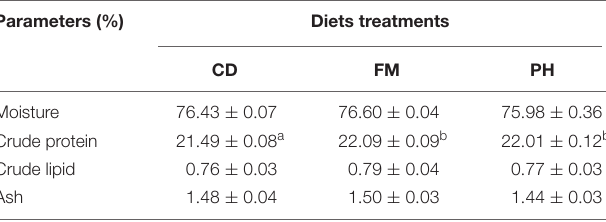
FIGURE 2 | Expression levels of tor , s6k and 4e-bp in muscle of shrimps fed with different diets for 6 weeks. Results are shown as the mean ± SE. Different letters indicate significant differences ( n = 3; P <